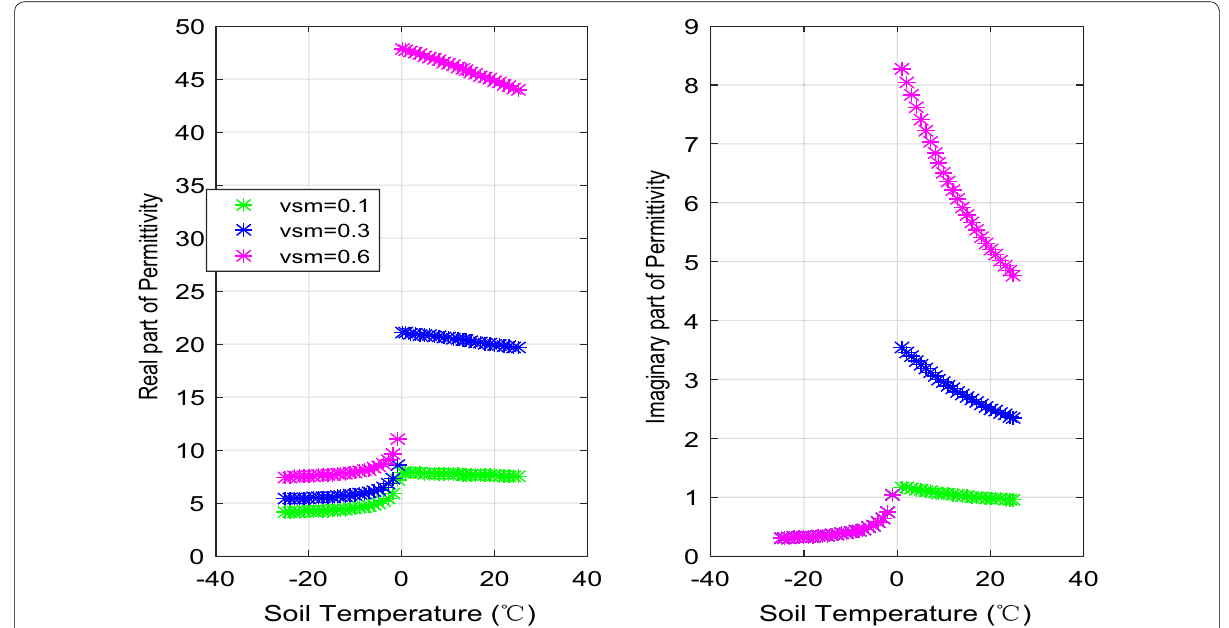
Fig. 2 Real part (left) and imaginary part (right) of the permittivity versus soil temperature at different soil moisture (vsm